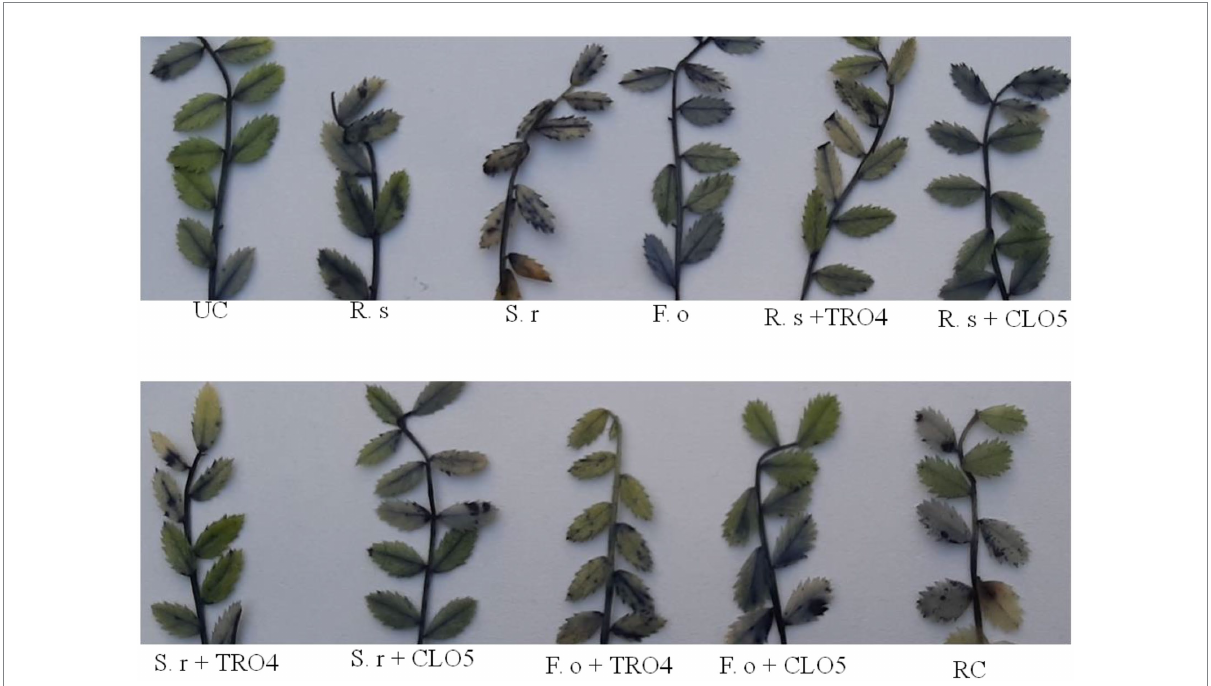
FIGURE 5 Effect of bacterial endophytes on the accumulation of superoxide radicals in chickpea leaves. UC, Un-inoculated control in which neither pathogen nor bacterial strain inoculated; R.s, Rhizoctonia solani ; S.r, Sclerotium rolfsii ; F. o, Fusarium oxysporum f. sp. ciceri ; RC, Resistant cultivar.